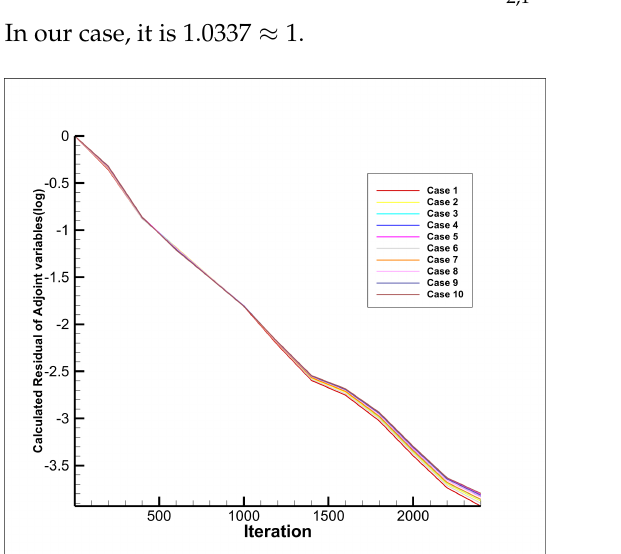
Figure 3. The residual of adjoint variables was calculated for 10 runs under the same mesh conditions, using the same input data as the example in the paper. These calculations were performed within a single loop consisting of 2400 iterations.